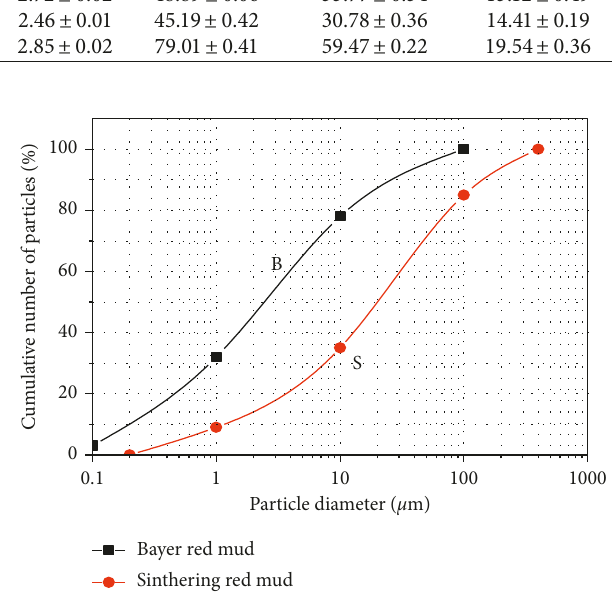
Figure 3: Particle size distribution curve of two kinds of red